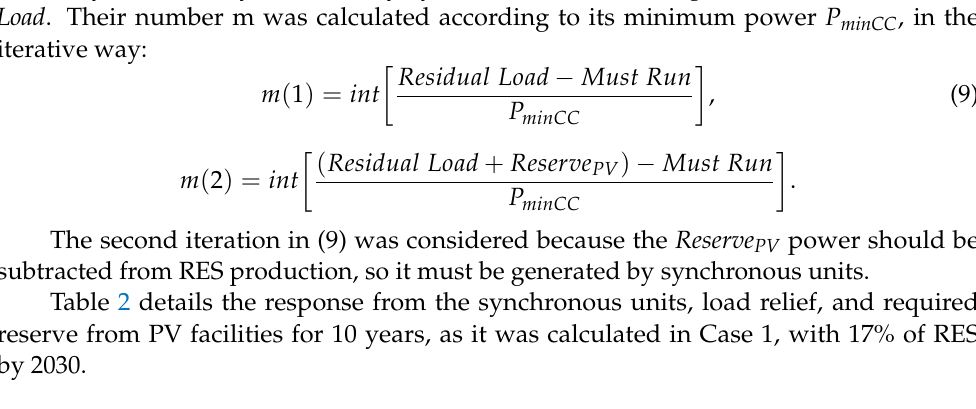
Table 2. Required Reserve from PV Facilities, Case 1–17%